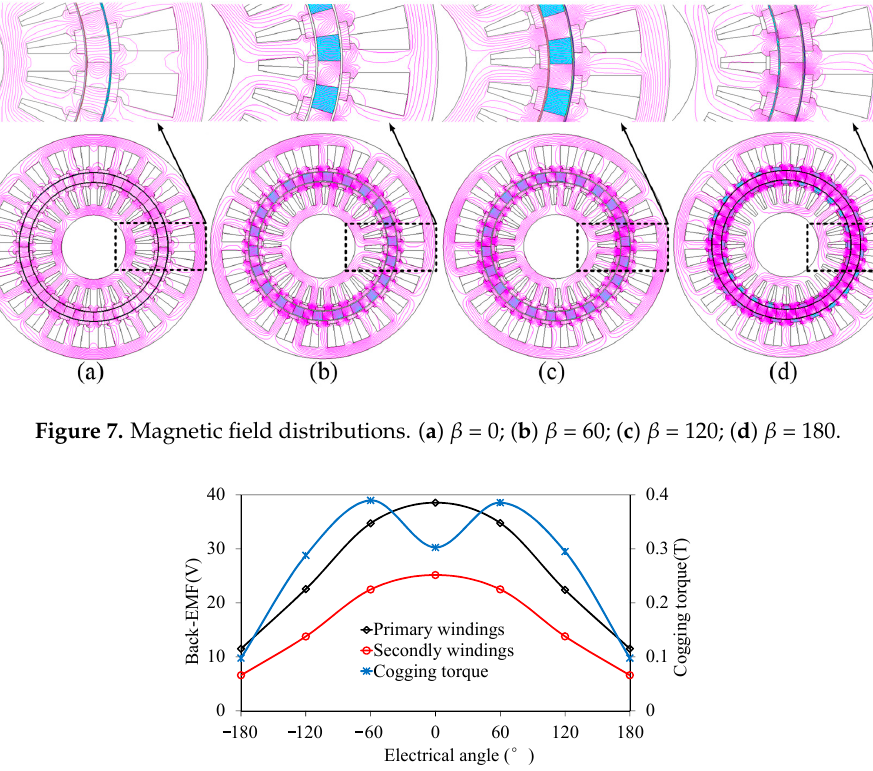
Figure 6. The relative position between outer stator and inner stator.